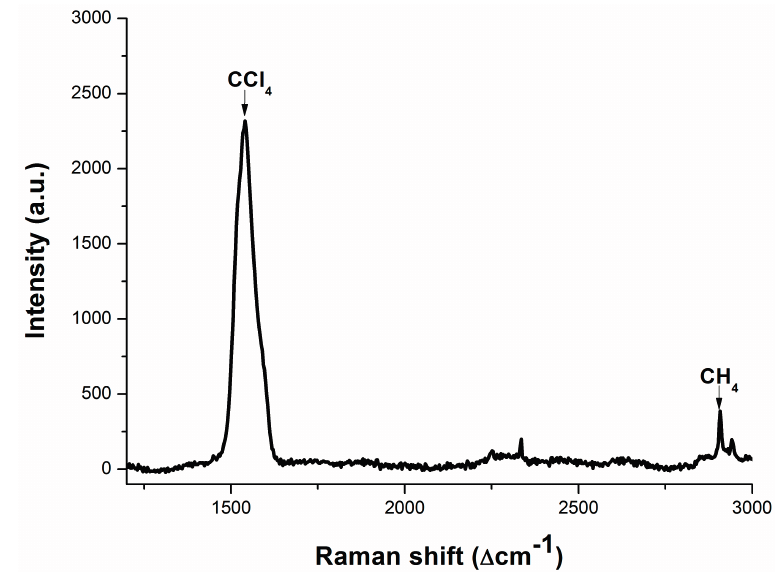
Figure 9. Raman spectrum of CCl 4 after extraction after conventional experimental